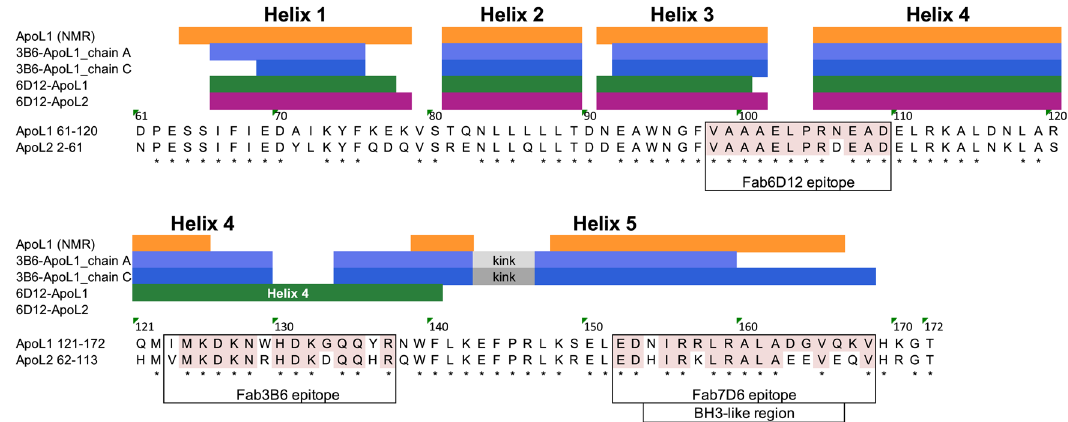
Fig. 5 Comparison of helix boundaries among the determined ApoL1 and ApoL2 structures. ApoL1-NTD and ApoL2-NTD sequences are aligned with the Fab epitopes in boxes and the conserved epitope residues highlighted in pink color. The helix boundaries, determined by using CCP4 and ProCheck, are shown for the four crystal structures and the ApoL1 NMR structure. The kink in the long ApoL1-helix 5 in the two Fab3B6 structures, due to the helix- breaking P145 residue, is shown as gray